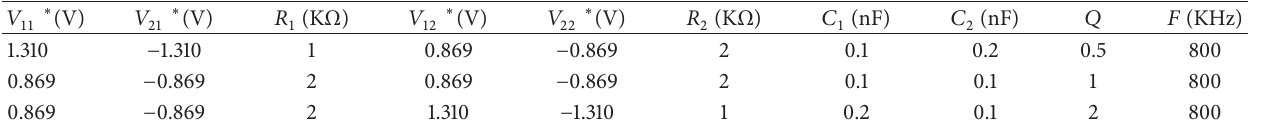
Table 3: Bias voltages/resistor values for orthogonal adjustment of 𝑄 0 with 𝑓 0 .